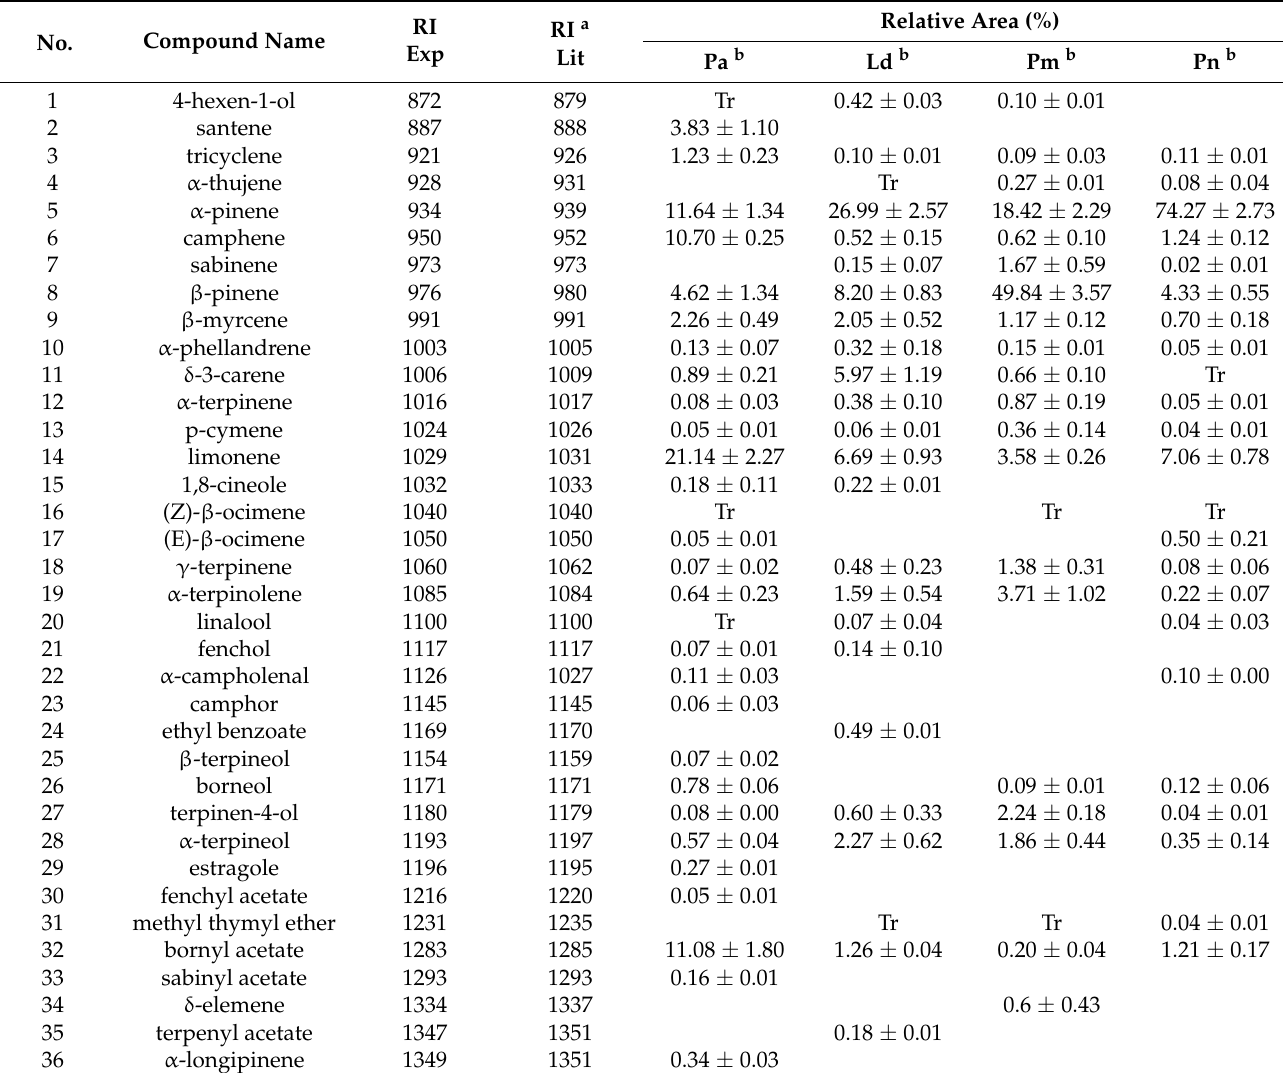
Figure 1. Chromatogram of the P. abies essential oil. Table 1. The chemical composition of P. abies , L. decidua , P. menziesii and P. nigra EOs obtained by gas chromatography coupled with mass spectrometry.